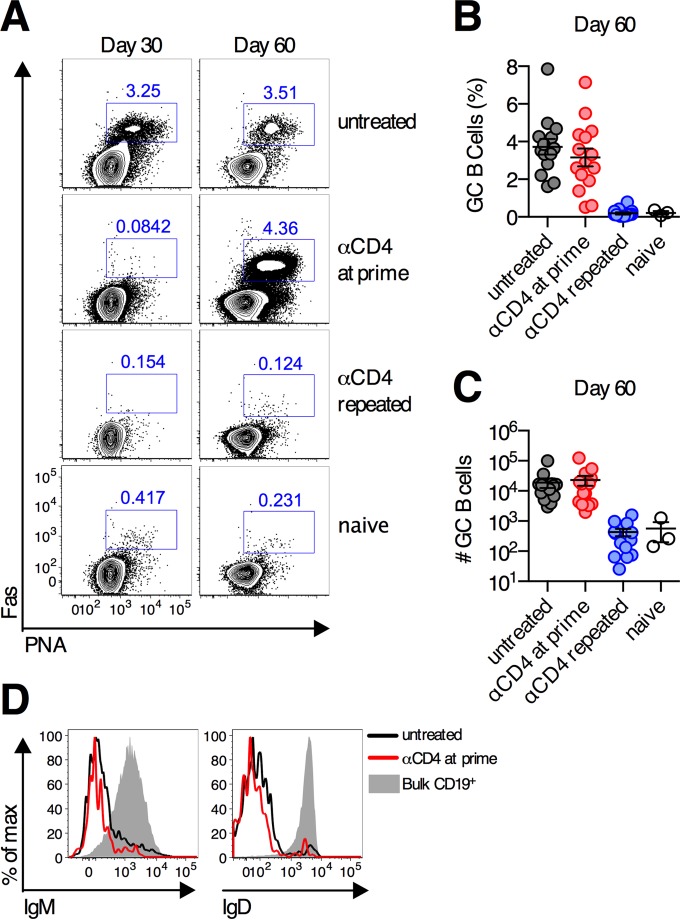
Germinal center B cell responses develop following transient depletion of CD4+ T cells. C57BL/6 mice were depleted of CD4 T cells a single time (anti-CD4 at prime) (red circles), depleted of CD4 T cells repeatedly (anti-CD4 repeated) (blue circles), or left untreated (gray circles) and immunized intramuscularly with 1010 vp of Ad26-SIV Env. (A to C) Representative flow cytometry plots (A), group average percentages (B), and absolute numbers (C) of germinal center B cells in the iliac (draining) LNs on day 60 postimmunization. (D) Expression of IgM and IgD on germinal center B cells on day 60 postimmunization. Each dot represents an individual mouse, and the means ± standard errors of the means are indicated by a line (n = 15/group pooled from three experiments).